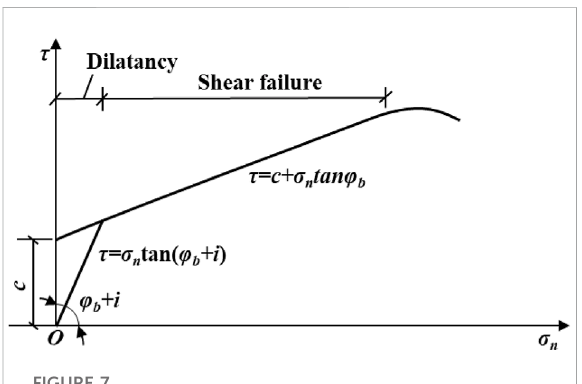
FIGURE 7 Relationship curve between the shear stress and normal stress of the structural plane (without considering cyclic shear).